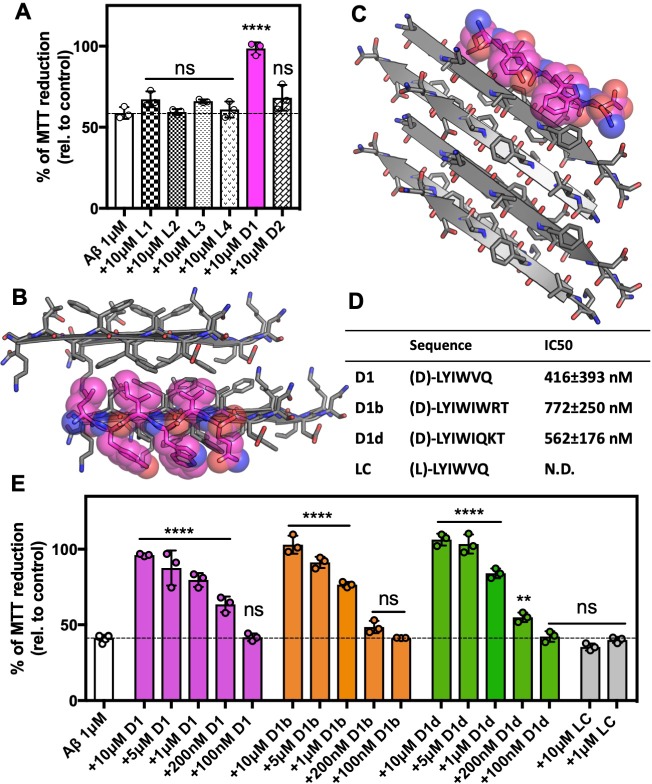
Development of inhibitors of Aβ fibril formation using structure-based design against Aβ 16–26 D23N.(A) Identification of Aβ1–42 inhibitor. 10 μM Aβ1–42 was incubated alone or with 100 μM of each candidate peptide inhibitor for 12 hr at 37°C and then diluted 1:10 with pre-plated N2a cells. Cytotoxicity was quantified using MTT dye reduction Bars represent mean with individual technical replicates, error bars display one standard deviation (n = 3; ns = not significant; ****, p<0.0001 using an ordinary one-way ANOVA- Dunnett’s relative to leftmost column) (B, C) Segment KLVFFAEN, derived from the Aβ 16–26 D23N crystal structure, was used as the design target. Model of peptide inhibitor D1(magenta) bound to the design target, KLVFFAEN (gray). Smaller hydrophobic residues of D1 mimic interactions with the fibril interface on one side of the peptide (B), whereas the other side of the peptide positions large aromatic residues between Aβ residues, breaking possible further interactions (C). (D) Overview of peptide inhibitors in D and L amino acid conformations, as indicated, used in this study and their sequences. Peptide LC is the L-form cognate peptide of D-form peptide D1 and is the negative control for peptide inhibitor D1 and its derivatives D1b and D1d. IC50 values were determined using four parameter nonlinear fit for half maximal inhibition. N.D., not determined. (E) Peptide inhibitors D1, D1b, and D1d reduce the cytotoxicity of Aβ1–42 in a dose dependent manner, whereas control peptide LC does not. 10 μM Aβ1–42 was incubated alone or with various concentrations of each peptide inhibitor for 12 hr at 37°C and then diluted 1:10 with pre-plated N2a cells. Cytotoxicity was quantified using MTT dye reduction. Bars represent mean with individual technical replicates, error bars display one standard deviation (n = 3–6; ns = not significant; **, p<0.002; ****, p<0.0001 using an ordinary one-way ANOVA Dunnett’s relative to leftmost column).10.7554/eLife.46924.008Figure 2—source data 1.Toxicity data points—Aβ incubated with inhibitors and inhibitor controls.